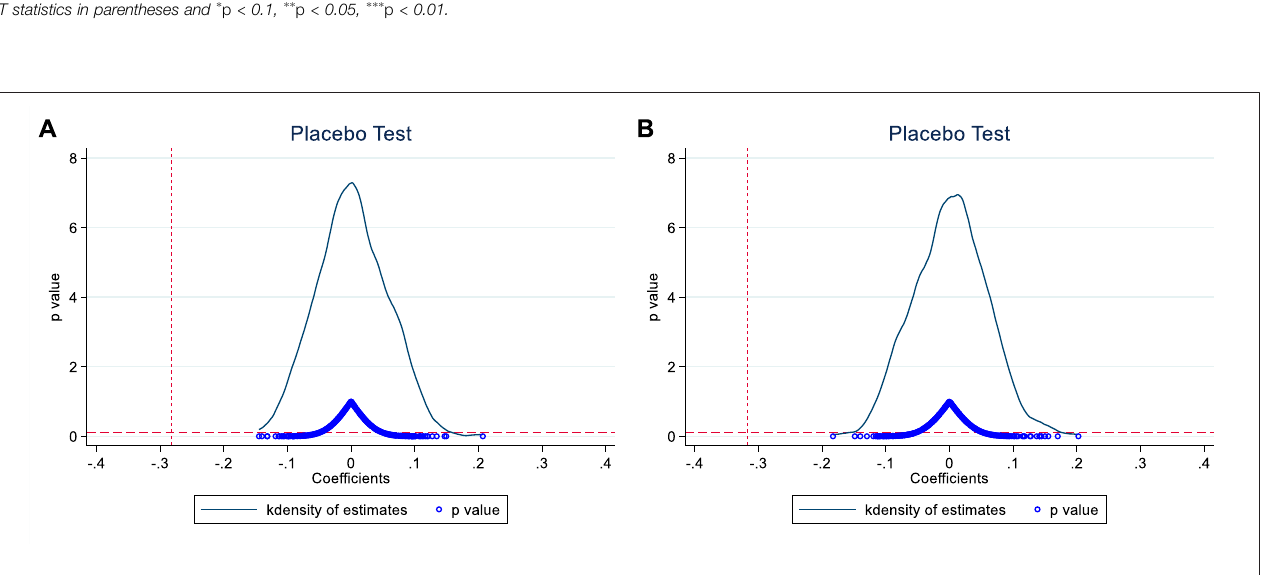
FIGURE 5 | Placebo test